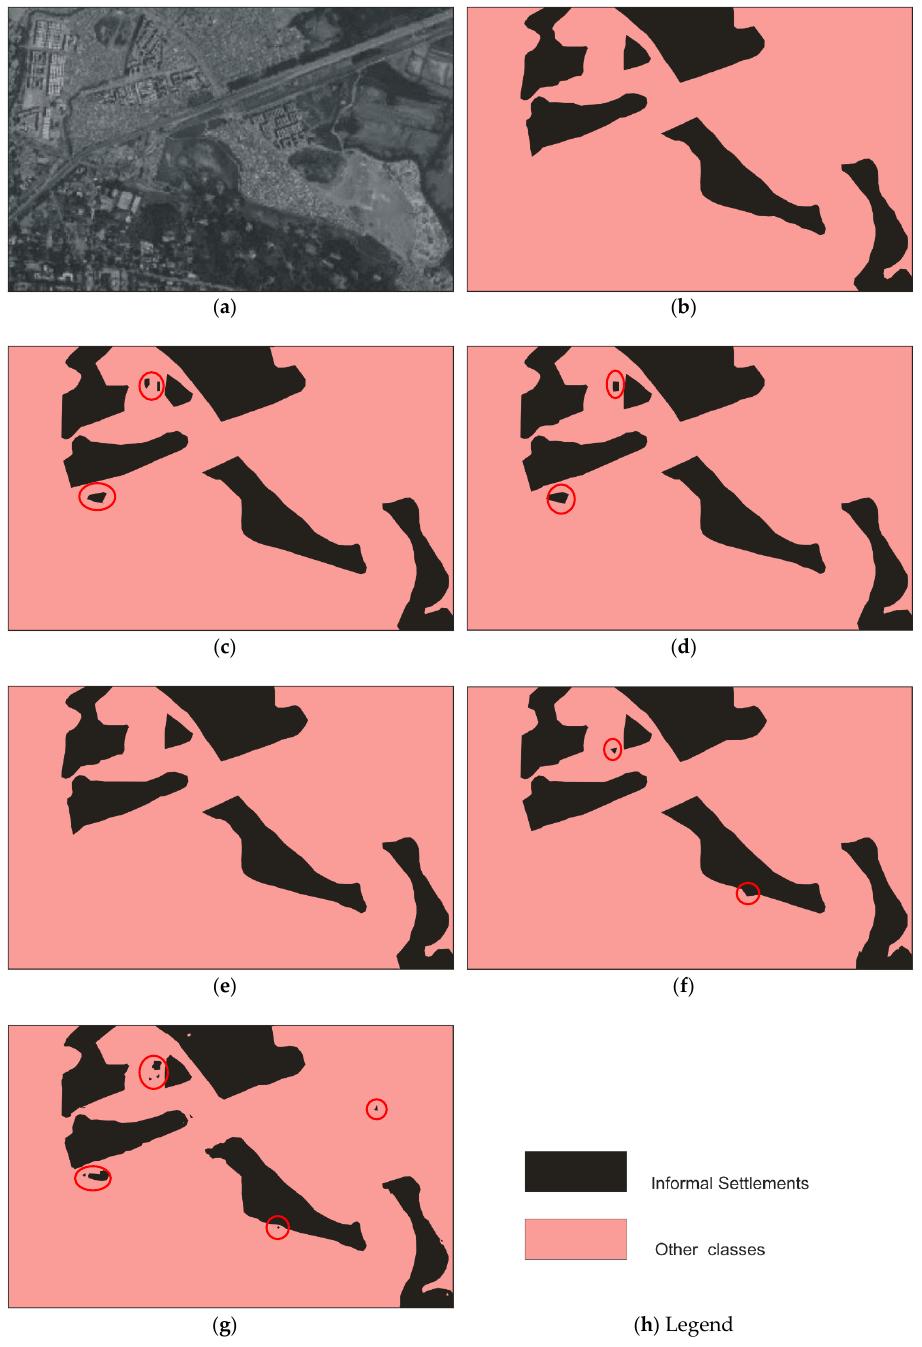
Figure 4. Informal settlement identification for parts of Mumbai city: ( a ) original image; ( b ) reference; ( c ) using plain U-net, with misclassifications circled in red; ( d ) using wavelet-assisted U-net, with misclassifications circled in red; ( e ) using contourlet-assisted U-net; ( f ) using contourlet texture features [20]; ( g ) using wavelet texture features [20]; ( h )